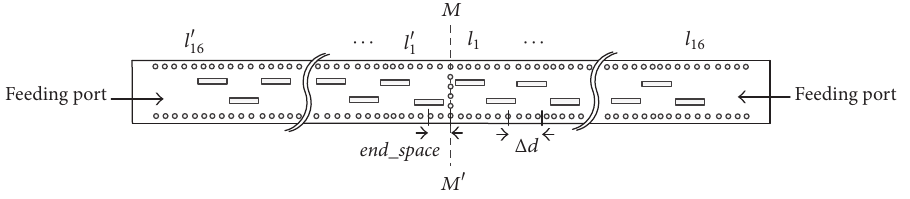
Figure 8: Configuration of the back-to-back SIW slot array antenna ( end space = 0.818 mm , and Δ𝑑 = 1 .335